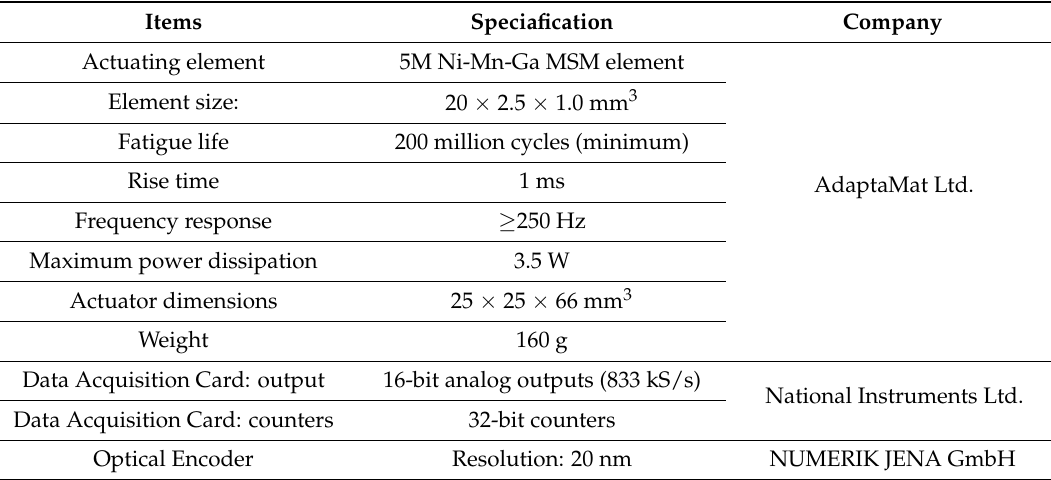
Figure 2. ( a ) Configuration of Test Rig; ( b ) Photo of the MSM actuator. Table 1. Specifications of the MSM actuator.